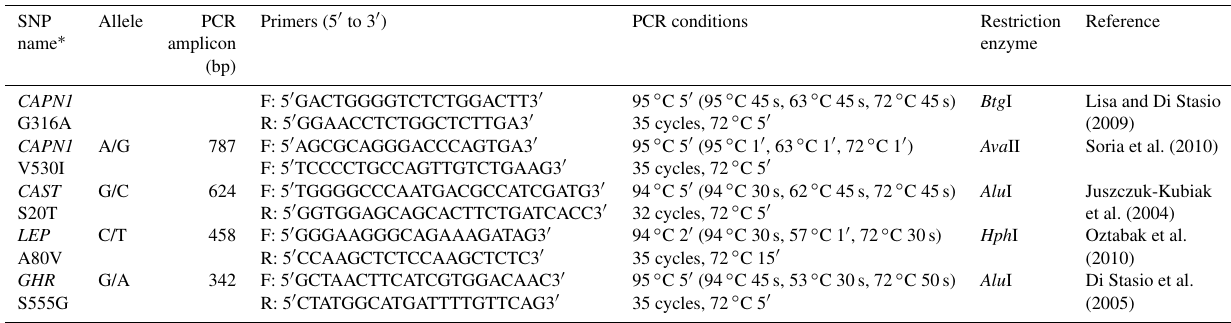
Table 1. Primers sequences (from 5 (cid:48) to 3 (cid:48) ), PCR conditions and restriction enzymes used for genotyping the polymorphisms in the current